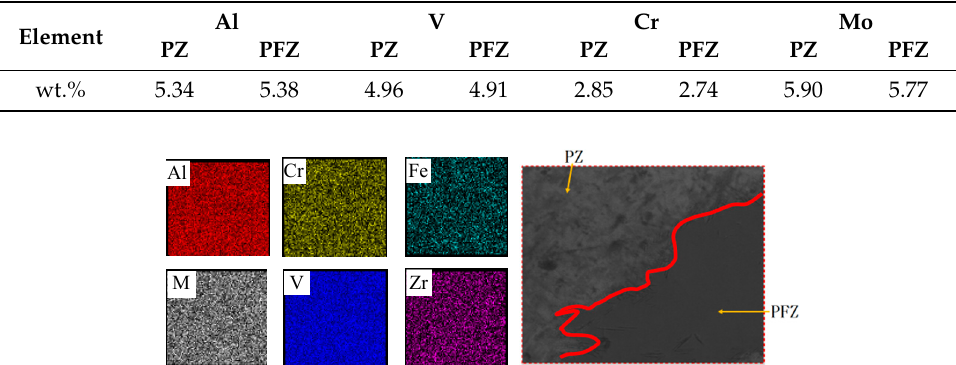
Figure 4. The distribution of elements of selected area and corresponding scanning area in energy disperse spectroscopy (EDS) test.